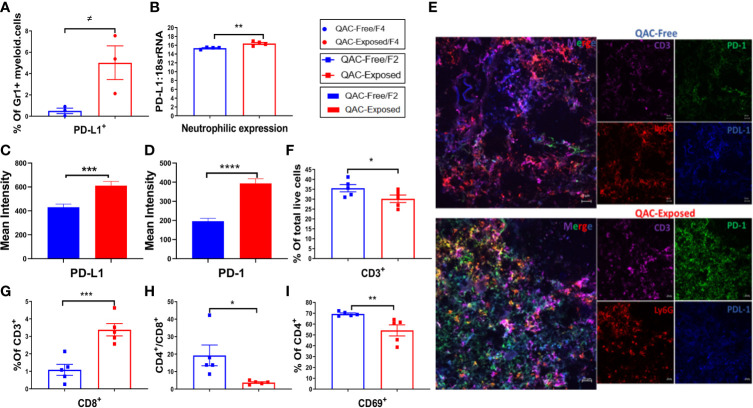
Reduced expansion and activation of splenic T cells with ambient exposure to QACs. (A) Percentage of splenic Gr-1+ myeloid cells expressing PD-L1. (B) Neutrophilic transcript level of PD-L1. (C–D) Quantification of the mean intensity of PD-L1 (C) and PD-1 (D) fluorescence in IHC-stained splenic sections. (E) Representative micrographs of IHC-stained splenic sections showing the co-localization of T-cell (CD3) expression of PD-1 and neutrophil (Ly6G) expression of PD-L1. (F) Percentage of CD3+ splenic T cells in total live cells. (G) Percentage of CD8+ cells in splenic T cells. (H) The ratio of CD4/CD8. (I) Percentage of CD4+ T cells expressing the activation marker CD69. Data are represented as mean ± SEM. ≠P < 0.10, *P < 0.05, **P < 0.01, ***P < 0.001, ****P < 0.0001.